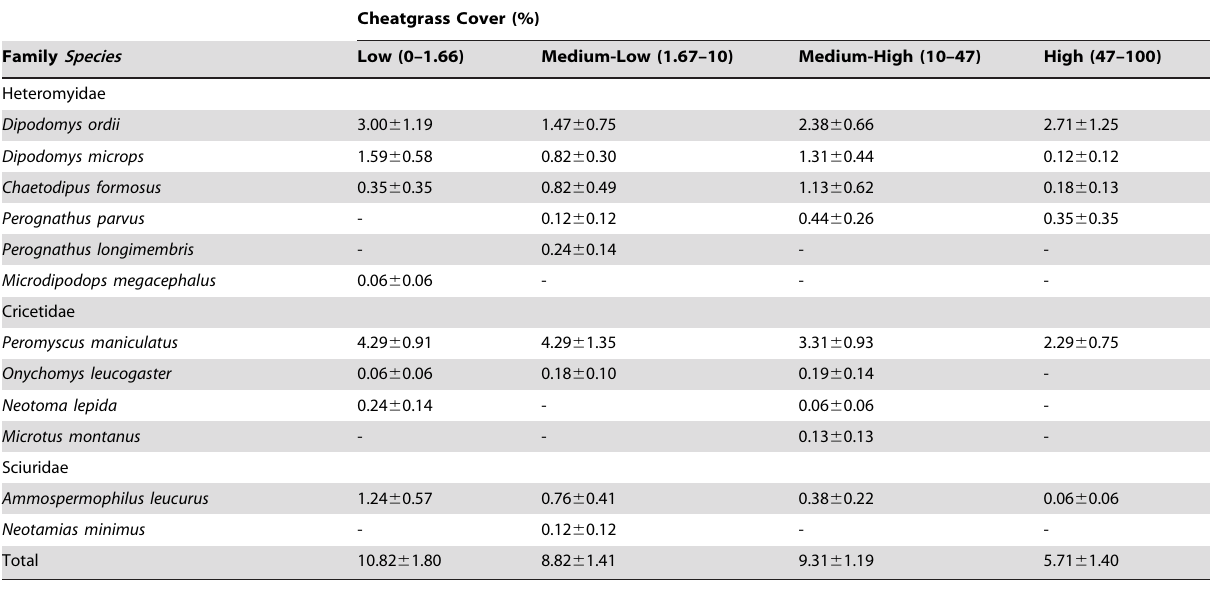
Table 1. Abundance of Small